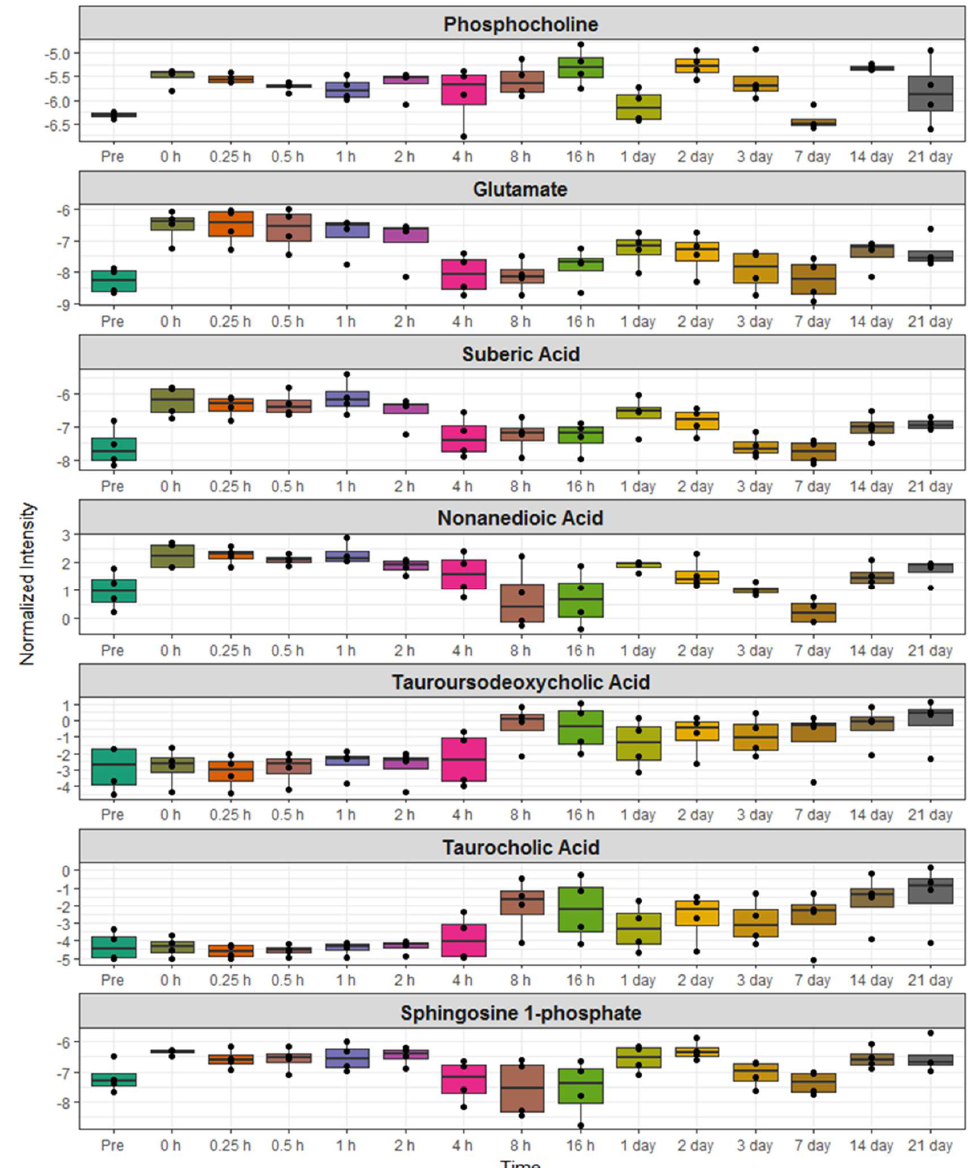
Figure 4. Time dependent transient changes in serum metabolite profiles that are unique to im administration of BIO 300 in NHPs.